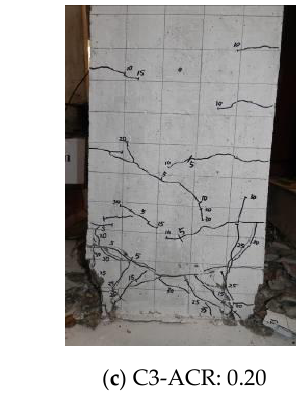
Figure 10. Failure pattern of tested RC columns with different axial compression ratios (ACRs).